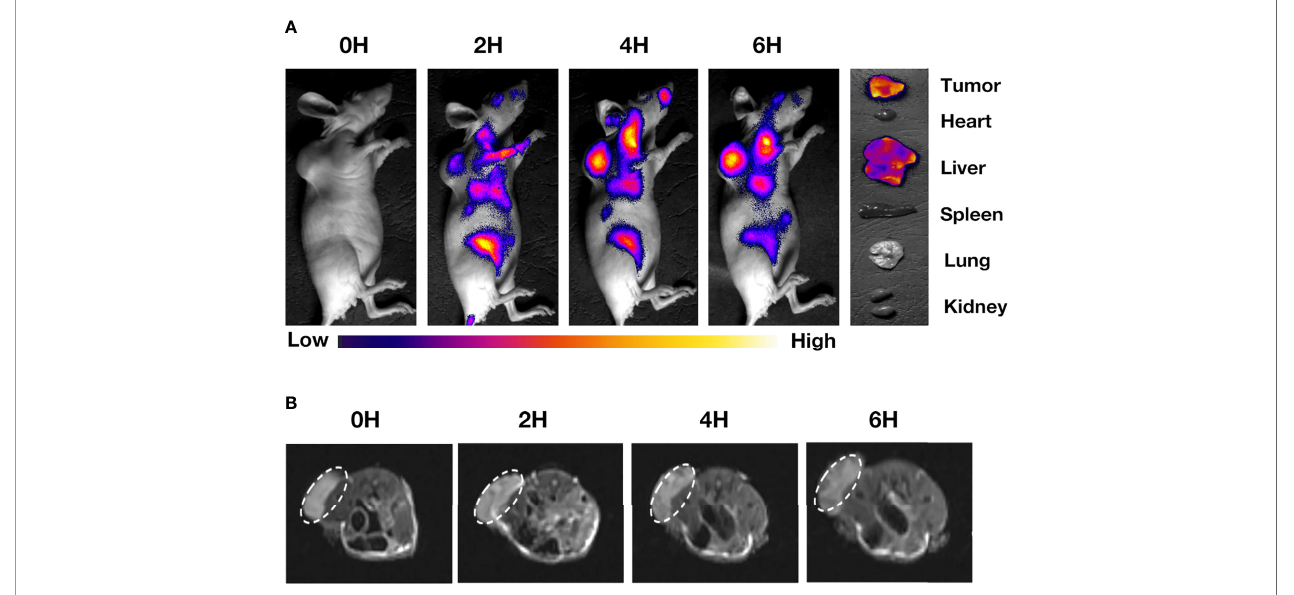
FIGURE 4 | (A) The distribution of drugs in tumors and main organs of mice after 0 h, 2 h, 4 h, and 6 h after injection of IR780@INPs-CTX via tail vein. (B) MRI T2- weighted imaging of mice in IR780@INPs-CTX groups at 0 h, 2 h, 4 h and 6 h after drug